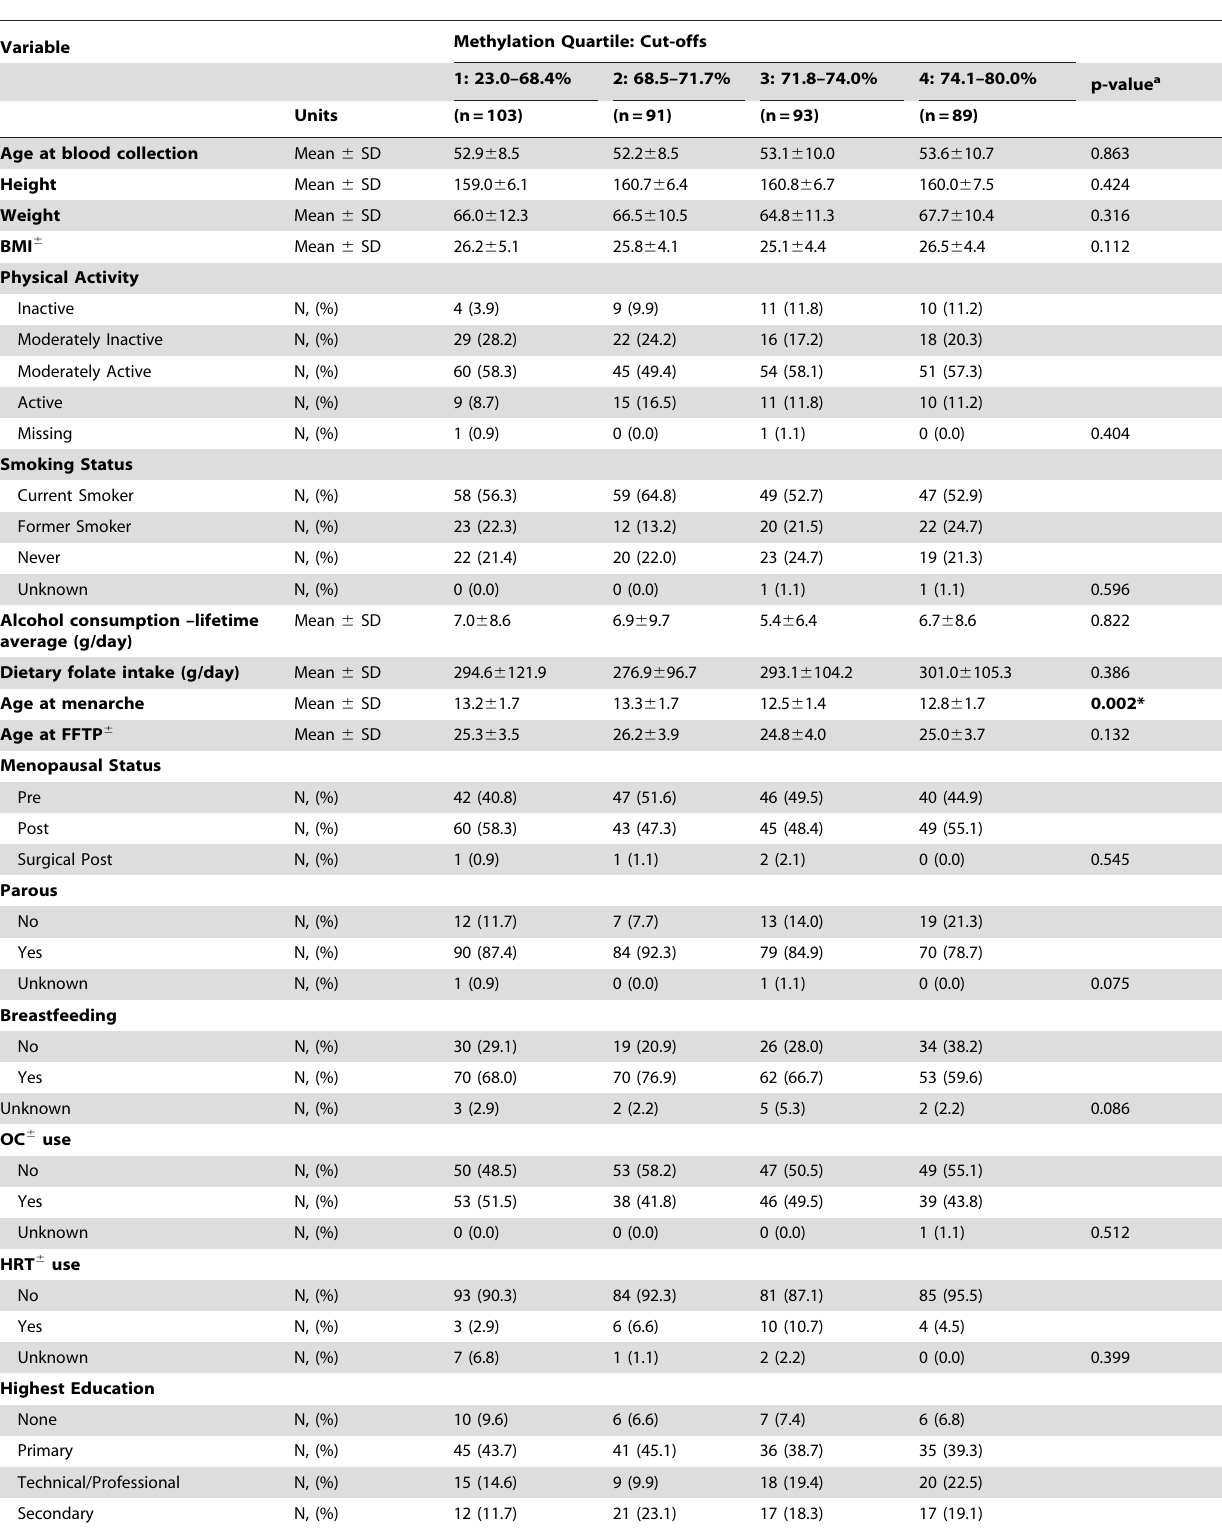
Table 2. Anthropometric and lifestyle variables in healthy controls with respect to LUMA genome wide methylation quartiles (Stage